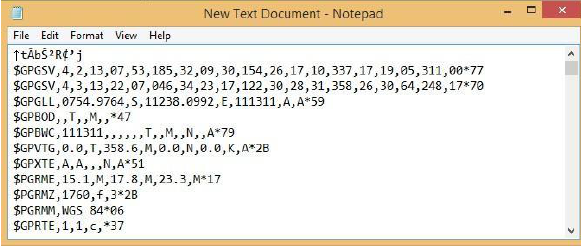
Figure 12. NMEA metadata and real encoded